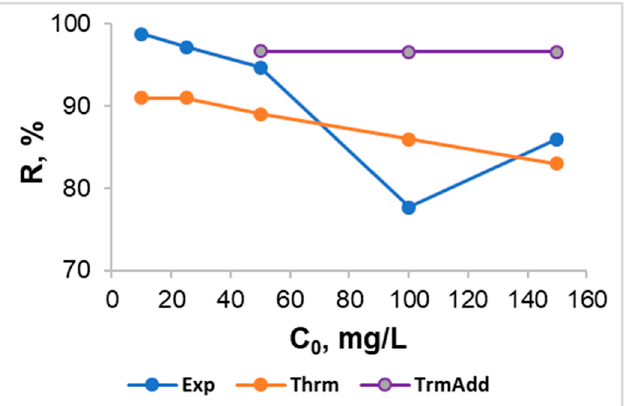
Figure 11. Total copper upload according to the experimental and model data depending on the initial content of copper in solution. The symbol TrmAdd refer to the amount of sorbent 2.5